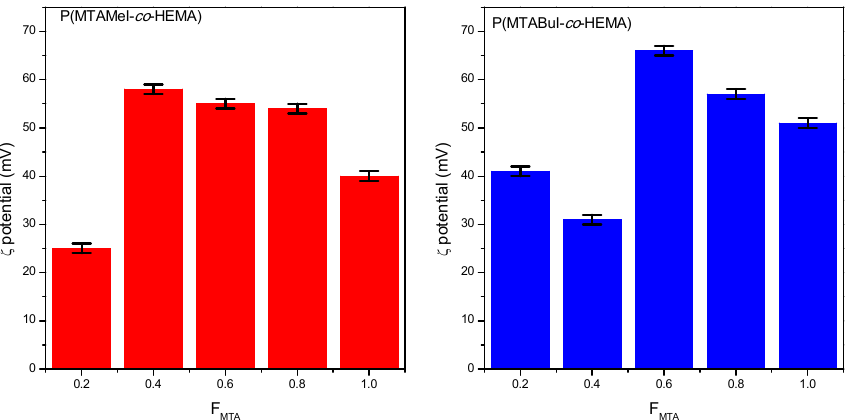
Figure 3. Variation of the ζ -potential of the quaternized copolymer series as a function of the composition.